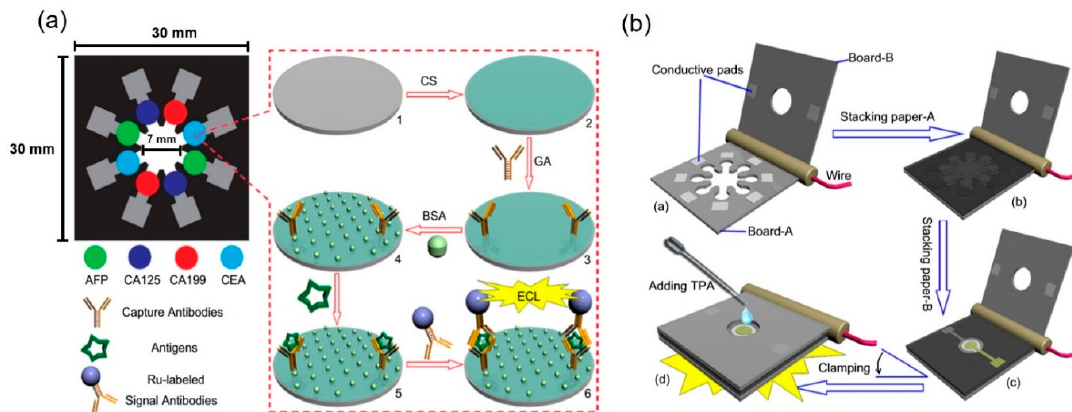
Figure 11. ( a ) Schematic representation of the platform features and assay procedures for this